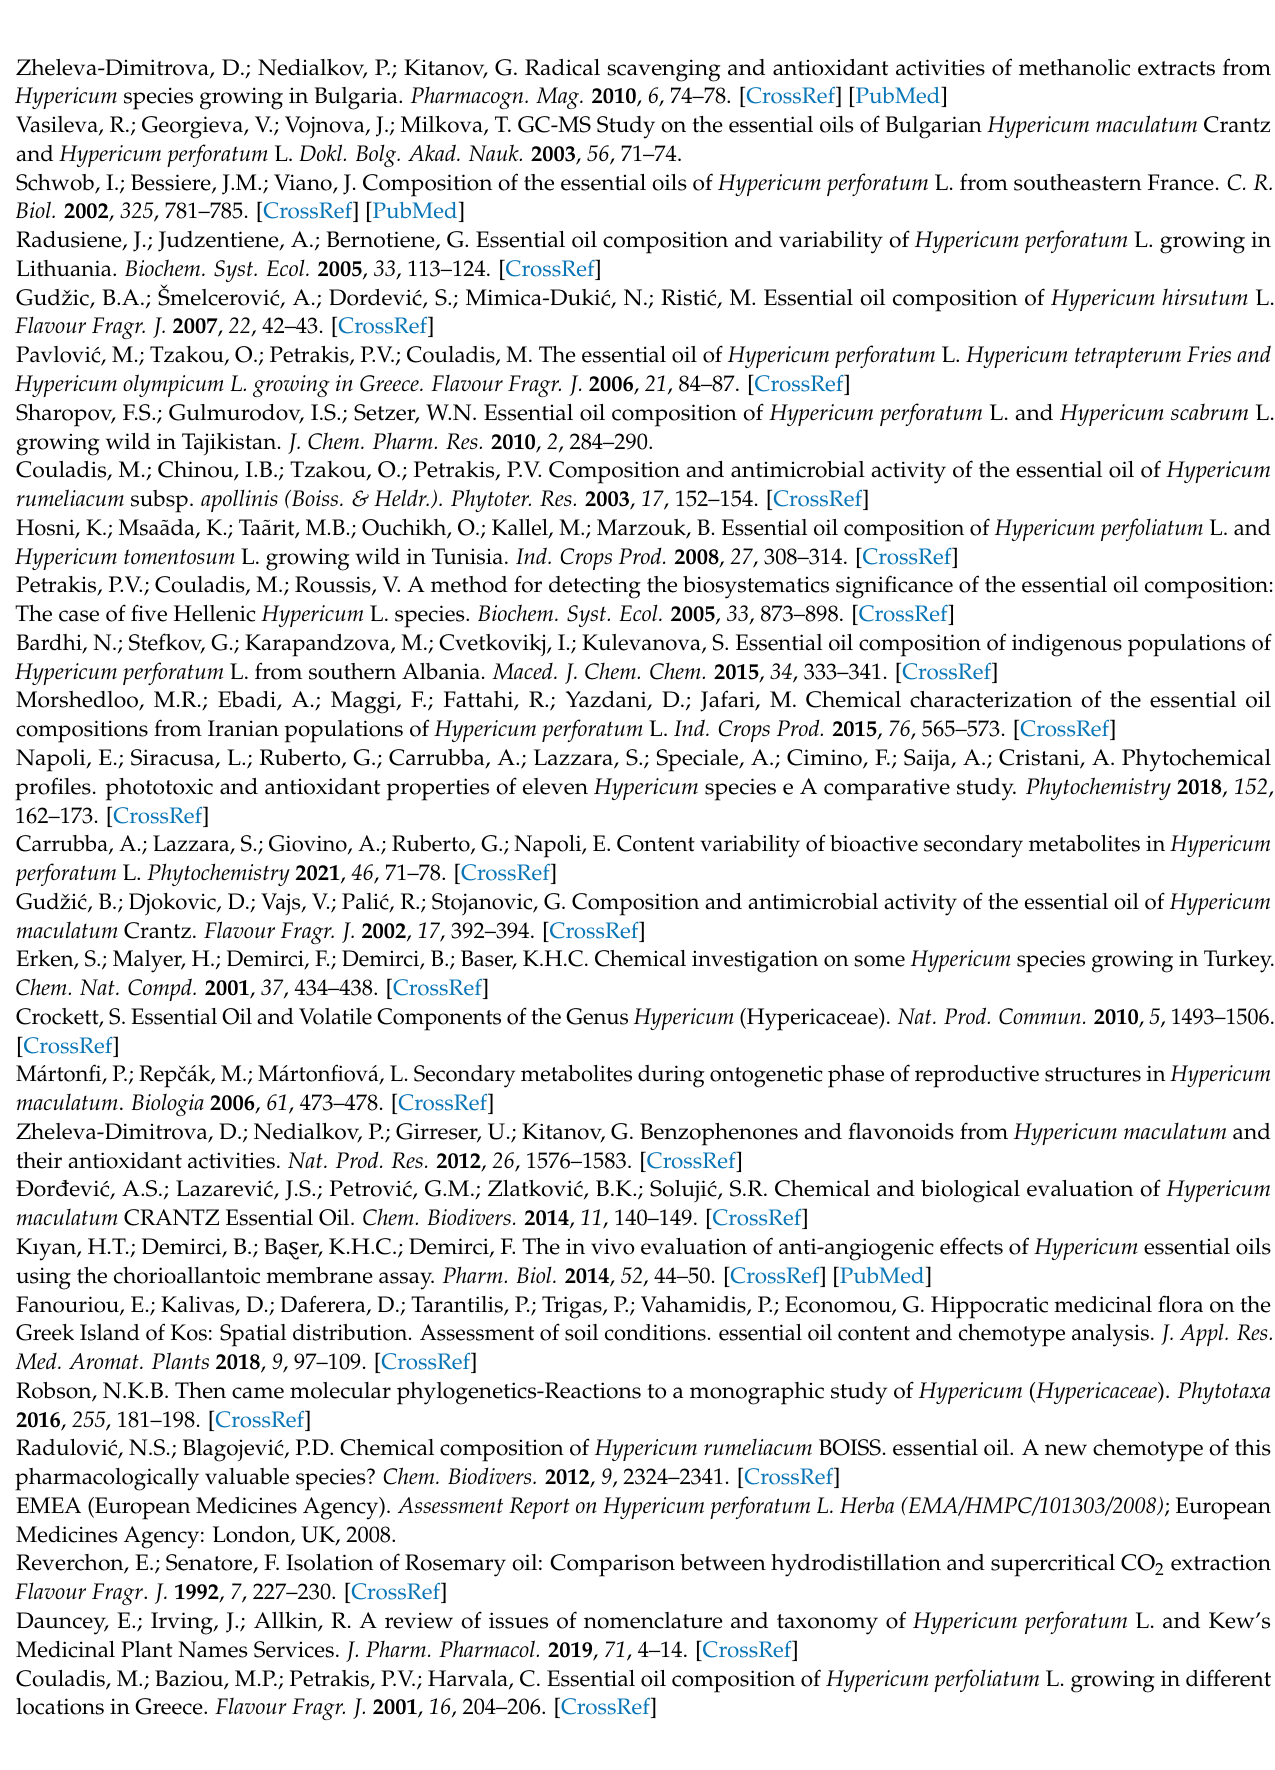
Table 5. The insecticidal effect of commercial EOs of H. perforatum from Bulgaria (Com, Bul) on two aphids (Rhopalosiphum padi and Sitobion avenae) (mean ± SD). After 24 h in % ± SD After 72 h in % ± SD EO Concentrations (%) S.